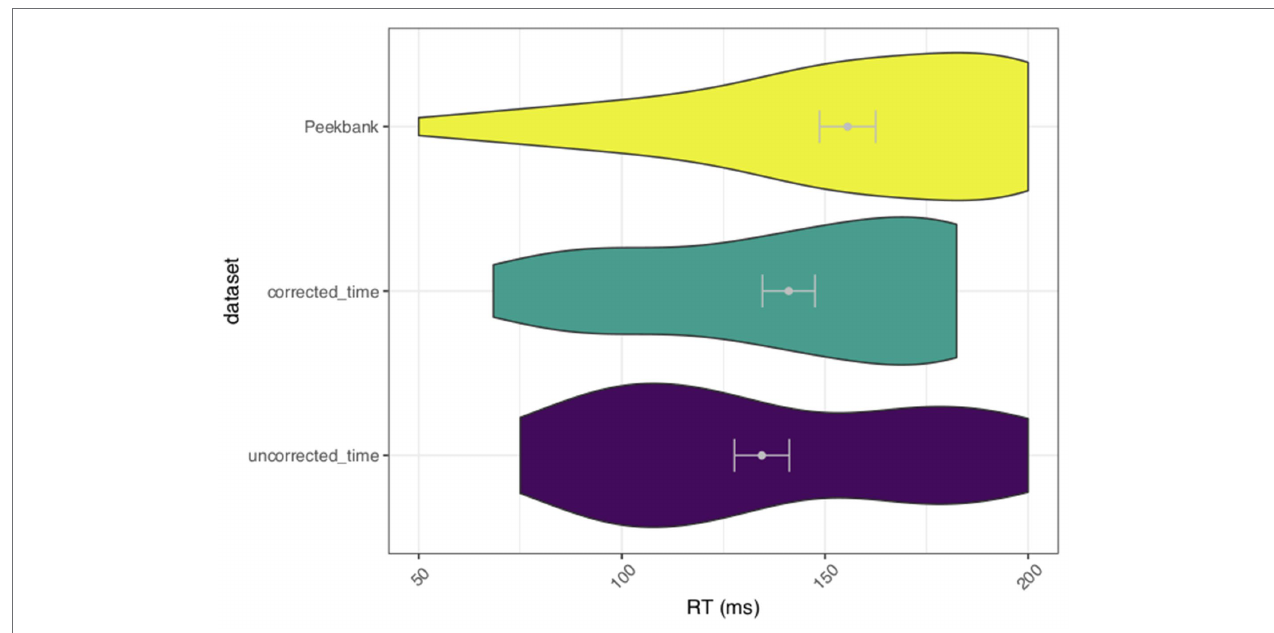
FIGURE 3 | Average latency to shift to the target from distractor during a window from − 300 to 200 between Peekbank data and the Study 1 corrected and uncorrected timing data. Error bars represent